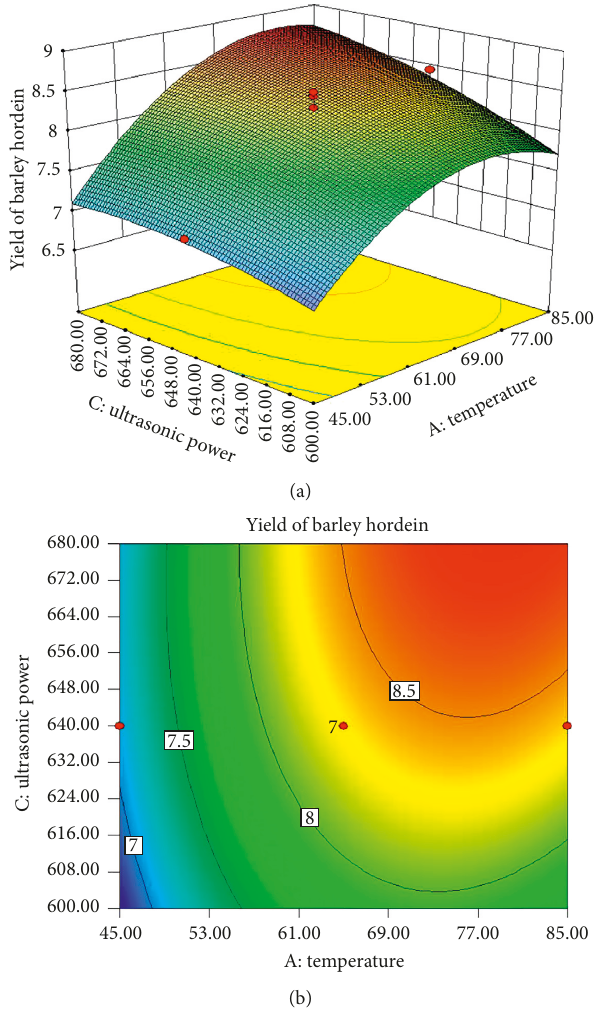
Figure 3: Response surface plot and contour plot showing the effect of temperature and ultrasonic power on the yield of barley hordein at microwave power 255W and extraction time 18min.